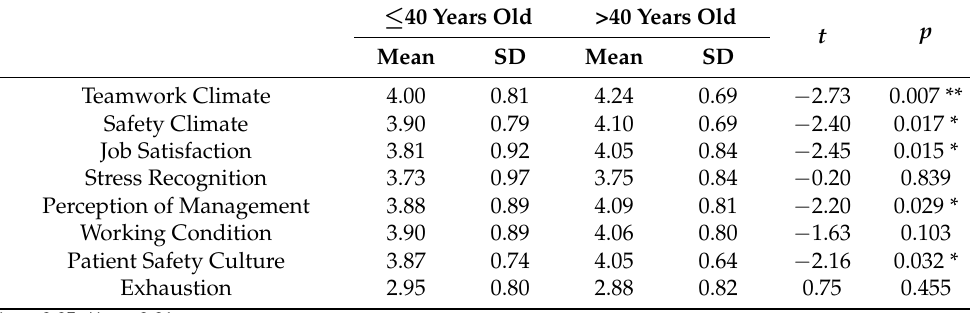
Table 3. Differences between means by age.